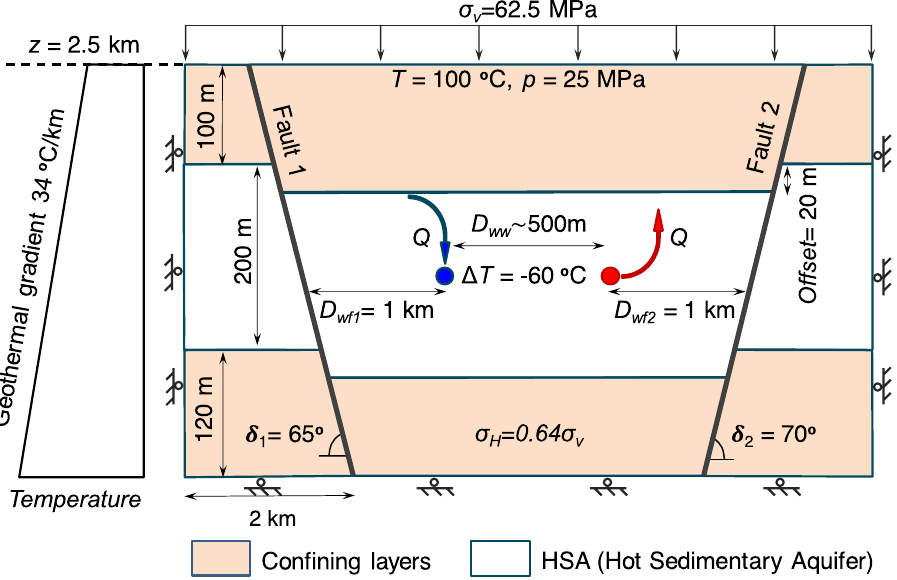
Figure 1. Model setup. The model includes a doublet for geothermal energy production in a Hot Sedimentary Aquifer (HSA) delimited by two normal faults, which may be either of low or high permeability (the sketch is not to scale). The model parameters are summarized in Table 1.